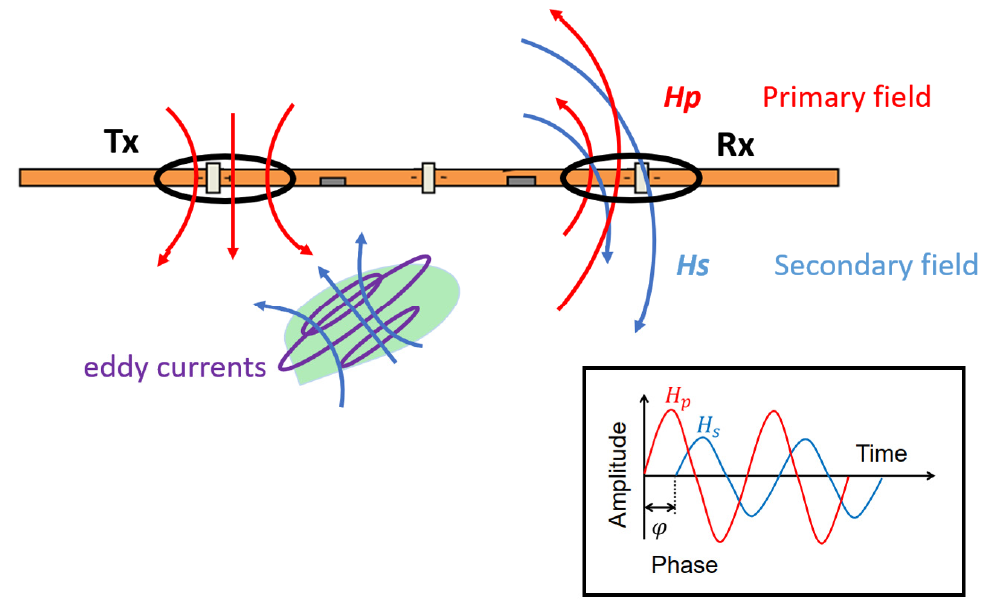
Figure 2. Schematic representation of a frequency-domain electromagnetic (FDEM) device, with the corresponding primary and secondary magnetic fields (Hp-Hs) amplitudes and phase lags.